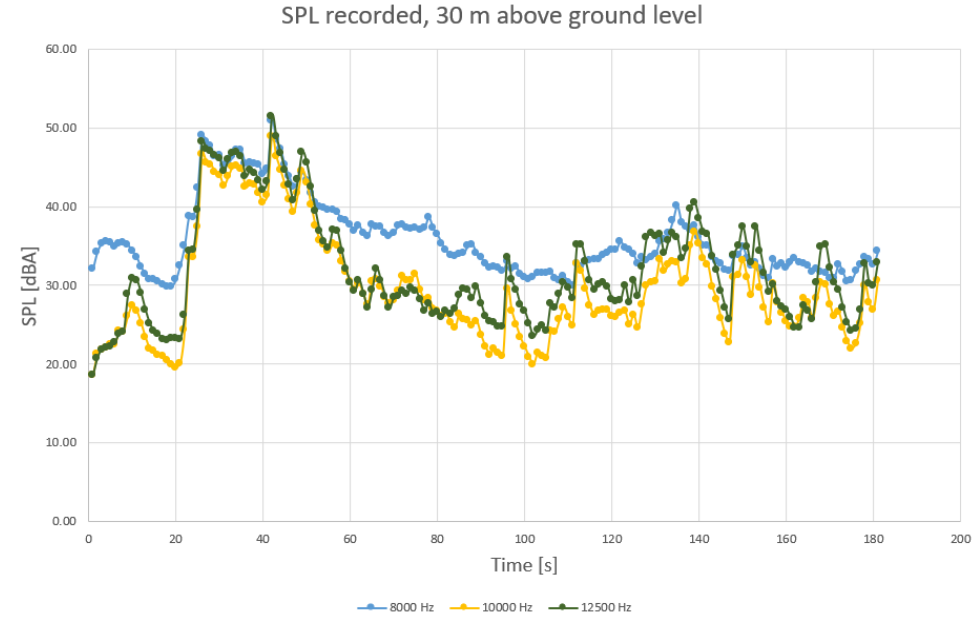
Figure 10. SPL recorded for medium frequency range, 30 m level (at 8 kHz, 10 kHz and 12.5 kHz, with blue—8 kHz, orange—10 kHz, and grey—12.5 kHz components).